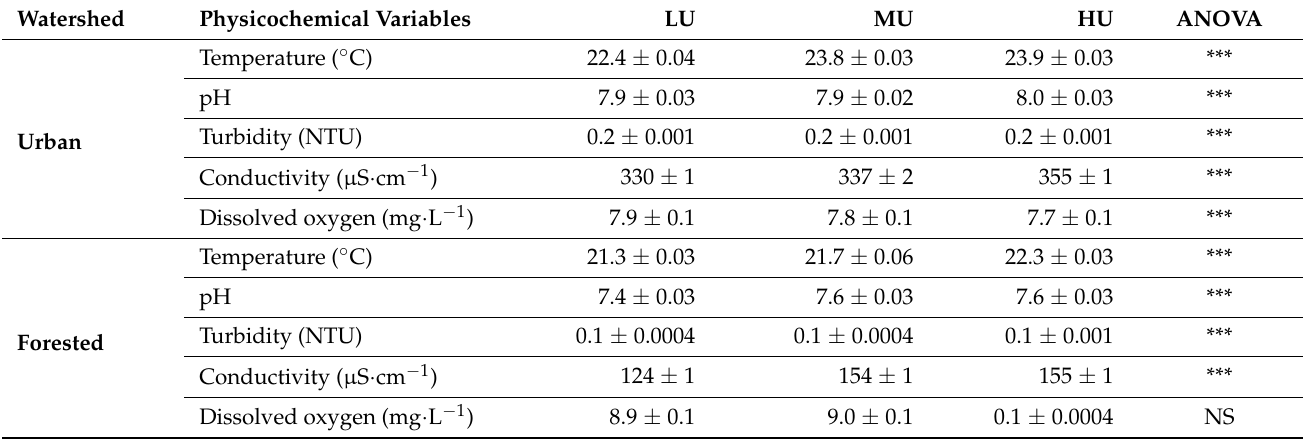
Table 2. The mean ( ± SE) physicochemical measurements in low urban (LU), medium urban (MU), and high urban (HU) reaches in the urban (R í o Piedras) and forested (R í o Sabana) watersheds. One-way ANOVA for comparison among reaches in each stream. NS—not significant at p = 0.05; *** p < 0.001.